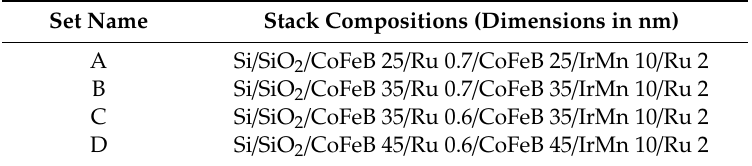
Figure 1. ( a ) Sketch of the CoFeB / Ru / CoFeB / IrMn / Ru synthetic antiferromagnet stacks grown via magnetron sputtering. t indicates the thickness of the CoFeB layers, ranging from 25 nm to 45 nm. d indicates the thickness of the Ru coupling layer, ranging from 0.6 to 0.7 nm; ( b ) room-temperature vibrating sample magnetometer hysteresis loop of sample C (CoFeB 35 nm, Ru 0.6 nm) in the as deposited sample measured along the easy axis (black line) and the sample after a field cooling at 250 ◦ C measured along the easy axis (red line) and hard axis (blue line). The colored arrows indicate the direction of the magnetization of top (purple) and bottom (orange) layers. H ex and H sat indicate the exchange field and saturation field related to the annealed sample, respectively. Table 2. List of the studied sample sets and corresponding stack